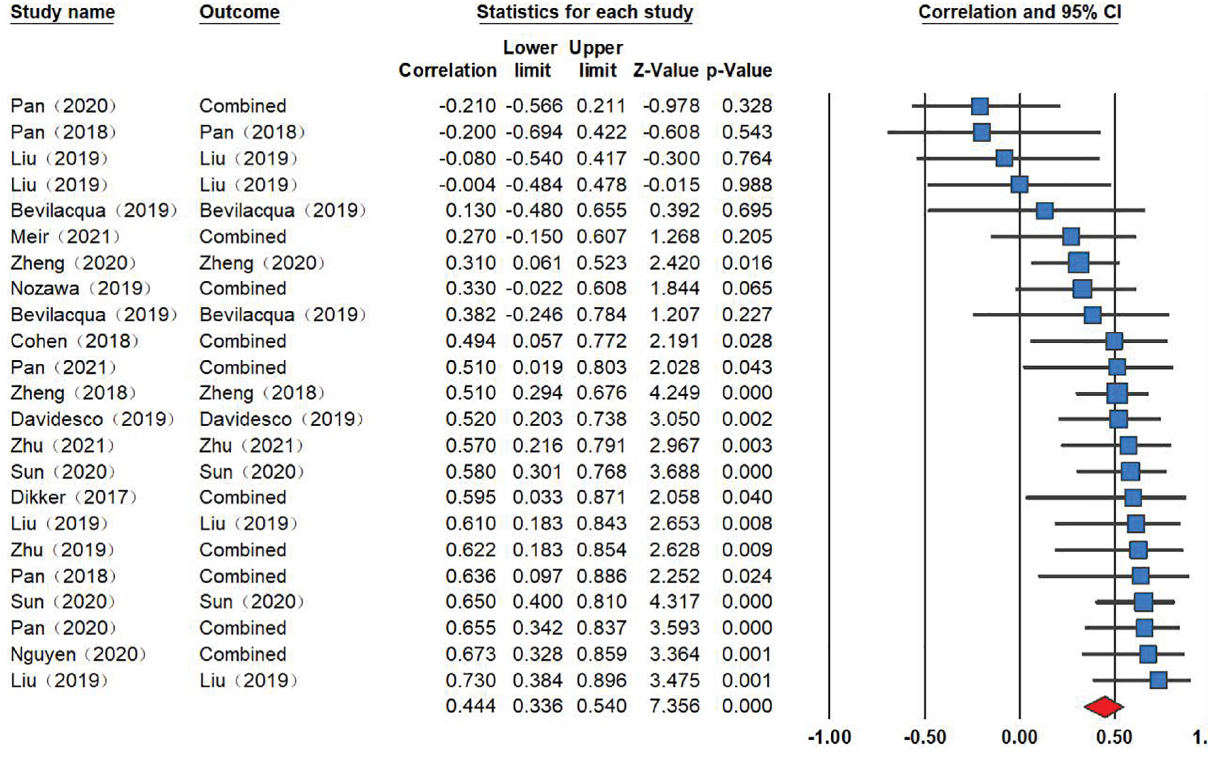
FIGURE 2 | Studies included in the meta-analysis investigating the relationship between INS and learning outcomes ( r = 0.444, p < 0.001, 95% CI [0.34, 0.54]). Effect sizes to the right of the zero mark indicate a positive relationship between INS and learning outcomes, whereas effect sizes to the left of the zero mark indicate a negative relationship between INS and learning outcomes. The middle point of the red filled diamond represents the overall effect size, and the two ends of the long diagonal line of the diamond represent 95% Confident Intervals (CI). The effect size of each independent sample is represented by the blue filled square, and the two ends of the line passing through the square represent 95% CI. The size of the square represents weight (i.e., contribution to meta-analysis). “Combined,” means when one study reported several effect sizes, these effect sizes would be synthesized via the “combination algorithms” function in CMA 3.3. To note, recurring studies represent different independent samples.